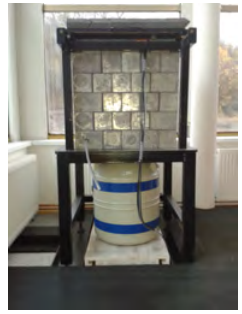
Figure 3. HPGe detector in Pb